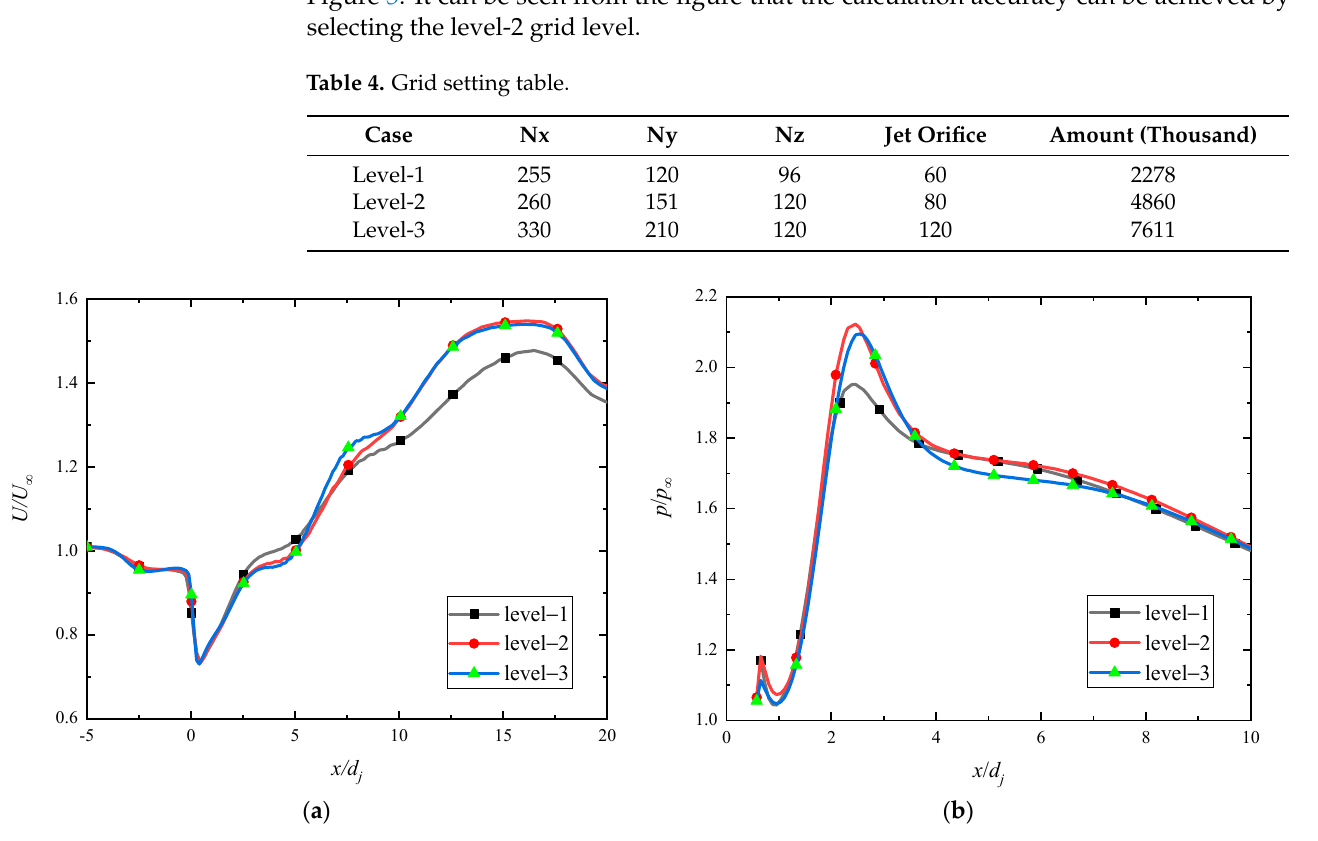
Figure 5. Normalized comparison diagram under different orders of magnitude grids. ( a ) Diagram of x direction velocity. ( b ) Diagram of wall